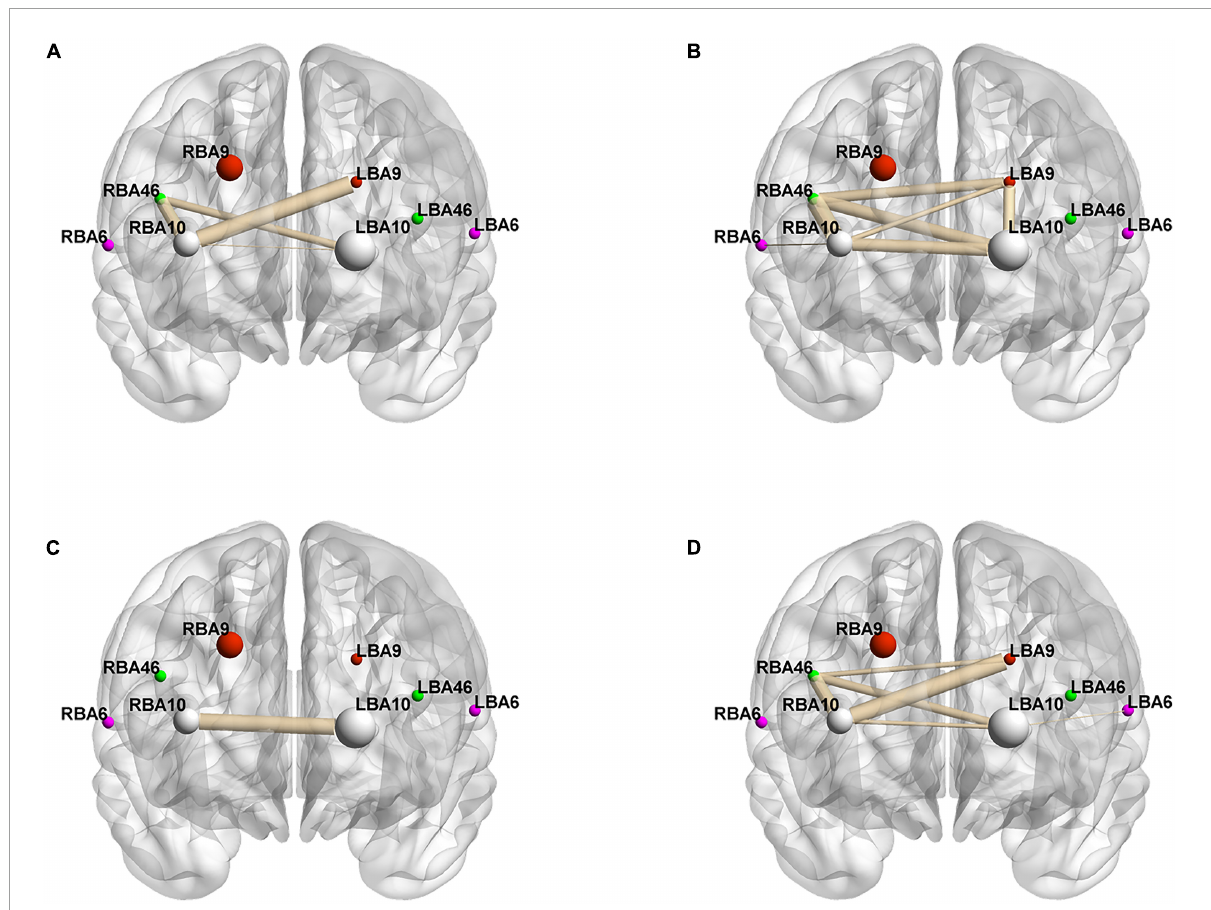
FIGURE4 Whole-brain connectivity of ROIs in the prefrontal lobe. (A,B) Portray whole-brain connectivity based on changes in HbO concentration in the control and intervention groups, respectively, and (C,D) portray whole-brain connectivity based on changes in HbR concentration in the control and intervention groups, respectively. Where the round spheres represent each of the 8 ROIs, the beige line segments indicate the correlation between the ROIs, and the thickness indicates the degree of correlation. To make the images clearer, only significant correlations are shown in the figure ( P < 0.05).